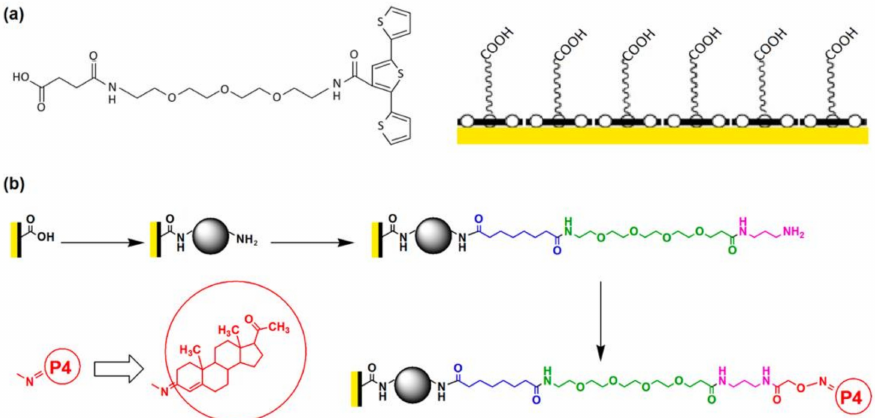
Figure 4. SPR gold chip preparation: ( a ) carboxylated terthiophene (T3C) molecule (left) and T3C SAM formed on gold surfaces (right); ( b ) in situ synthesis of progesterone (P4)-linker-ovalbumin on SPR gold. Reprinted with permission from ref. [304] Copyright 2019 Elsevier